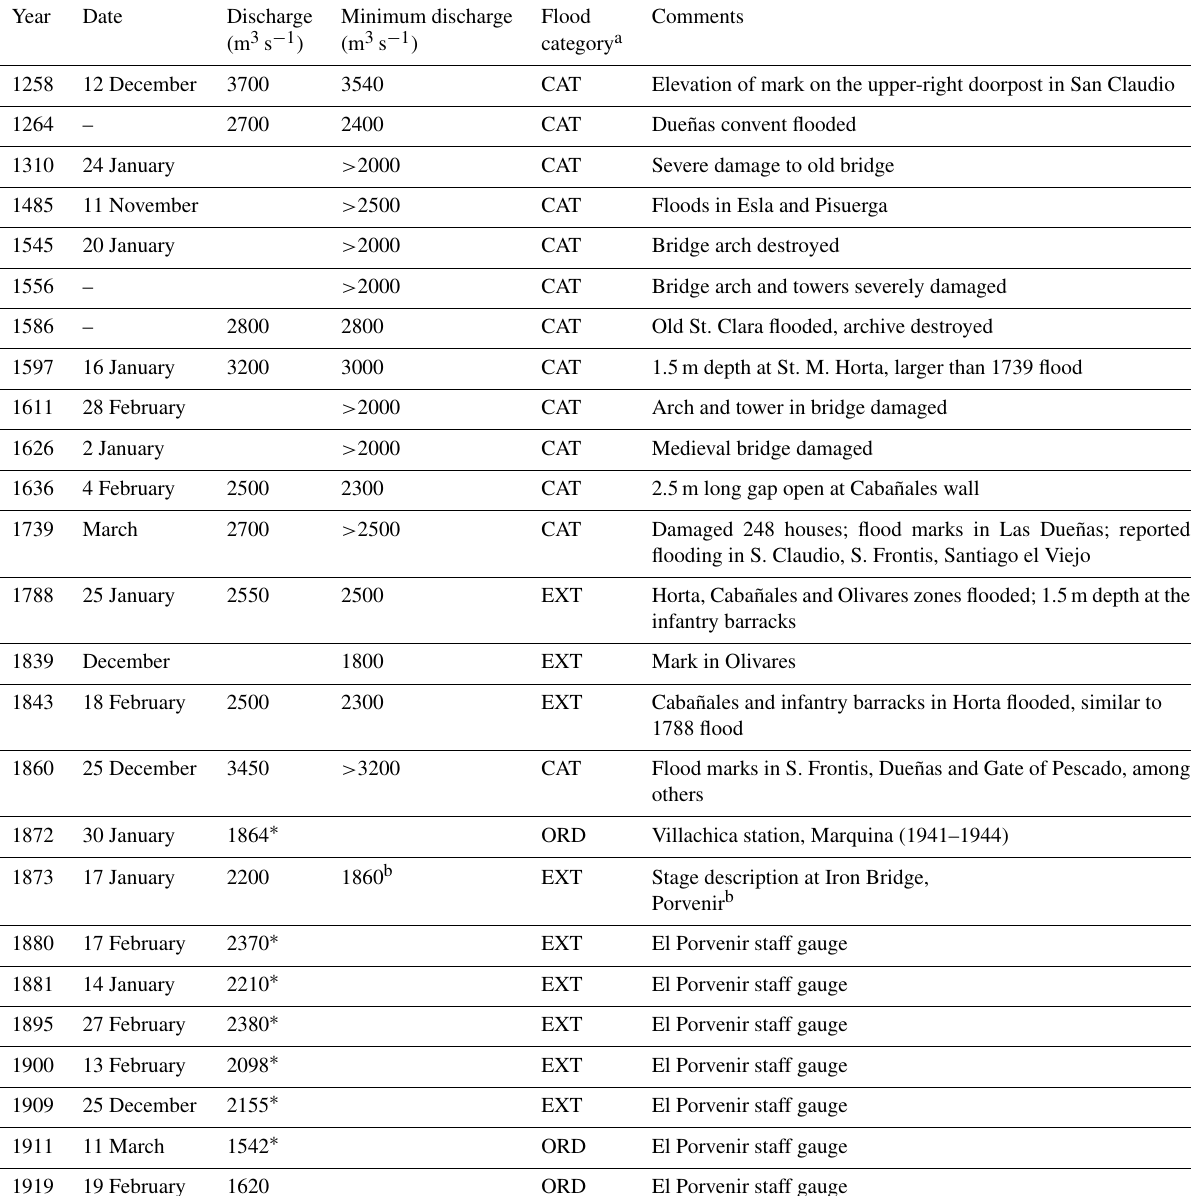
Table 1. Reconstructed discharges of the major historical floods in Zamora. CAT: catastrophic flood; EXT: extraordinary flood; ORD: ordinary